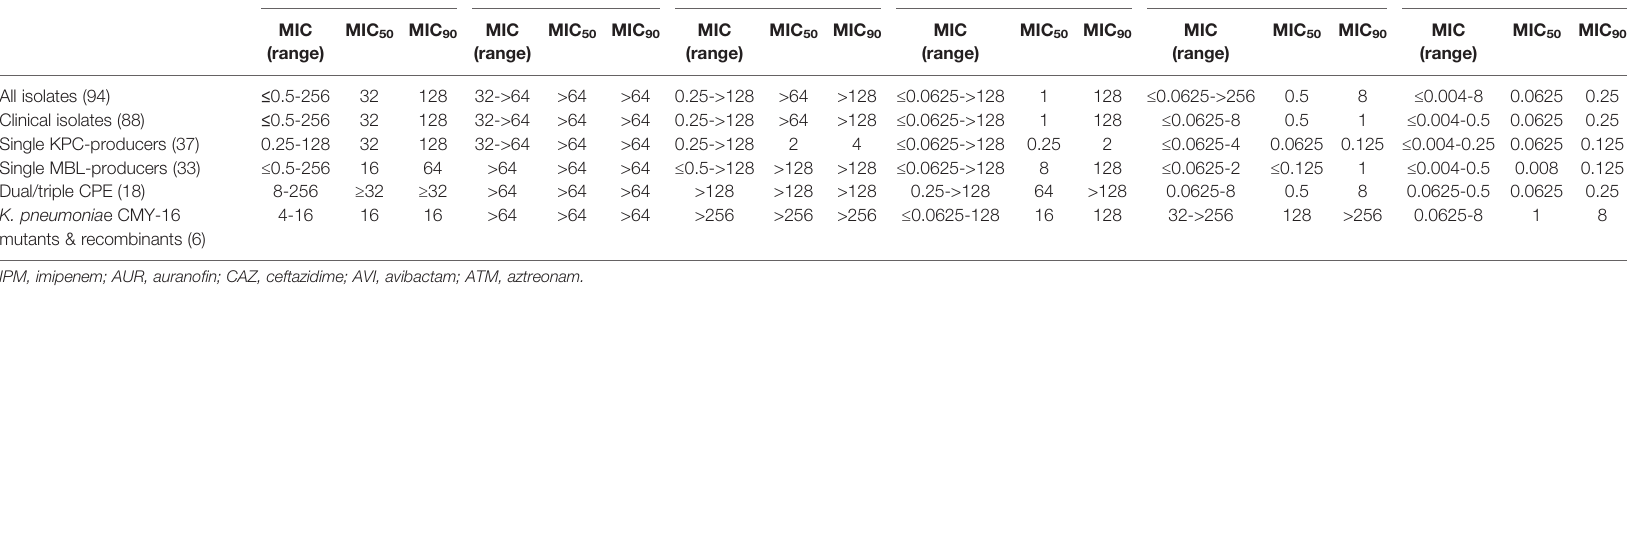
All isolates (94)